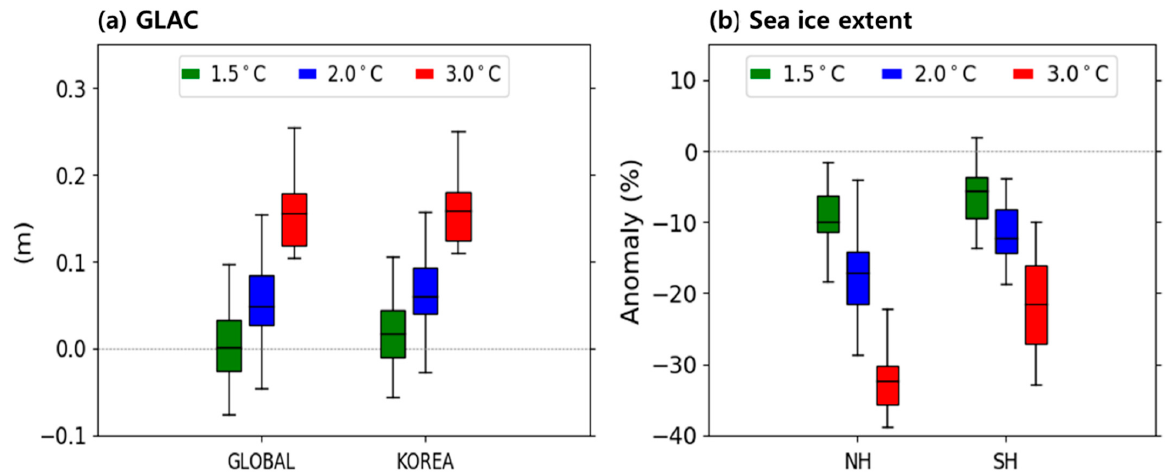
Figure 4. ( a ) Projected changes in GLAC contributions (unit: m) for global and KOR regions and ( b ) projected changes in the sea ice extent (unit: %) for the Northern and Southern Hemispheres relative to during the pre-industrial period. Green, blue, and red boxes indicate the T15, T20, and T30 climate targets, respectively.